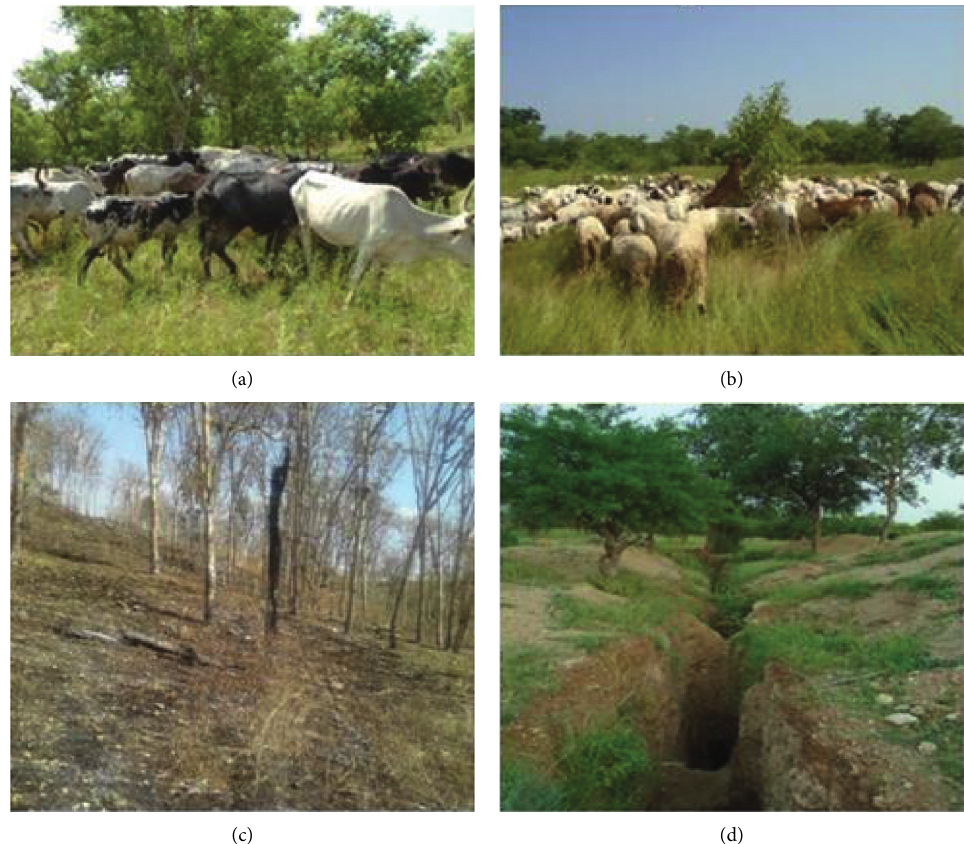
Figure 12: Photographs showing human-induced disturbances inside Kafta Sheraro National Park Forest: (a, b) Livestock browsing and grazing; (c) human-induced fire influence in Boswellia papyrifera dominated site; (d) traditional gold